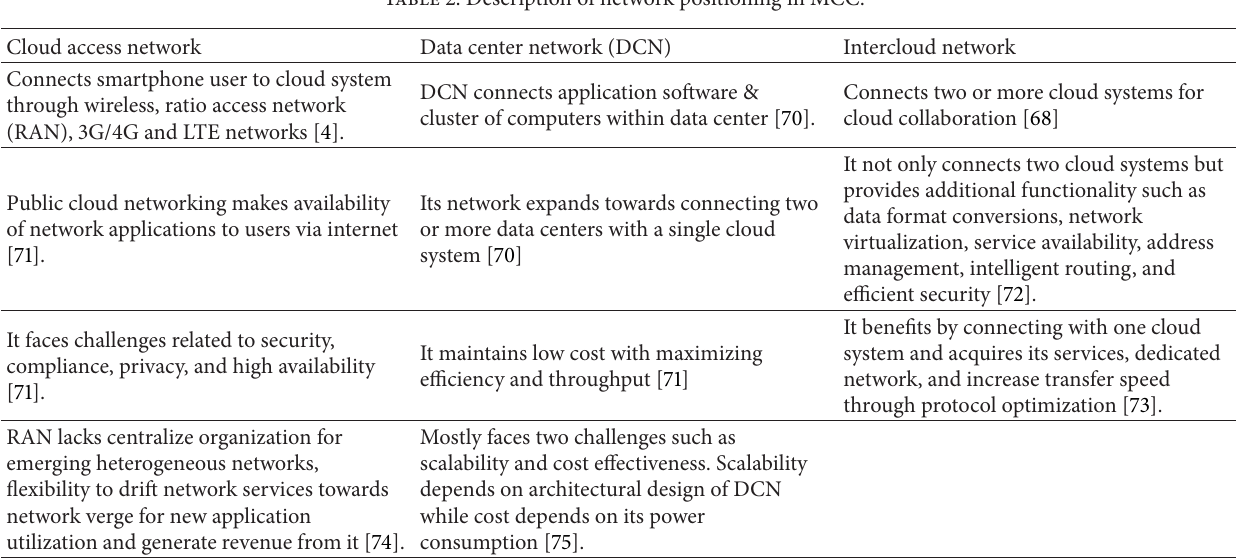
Table 2: Description of network positioning in